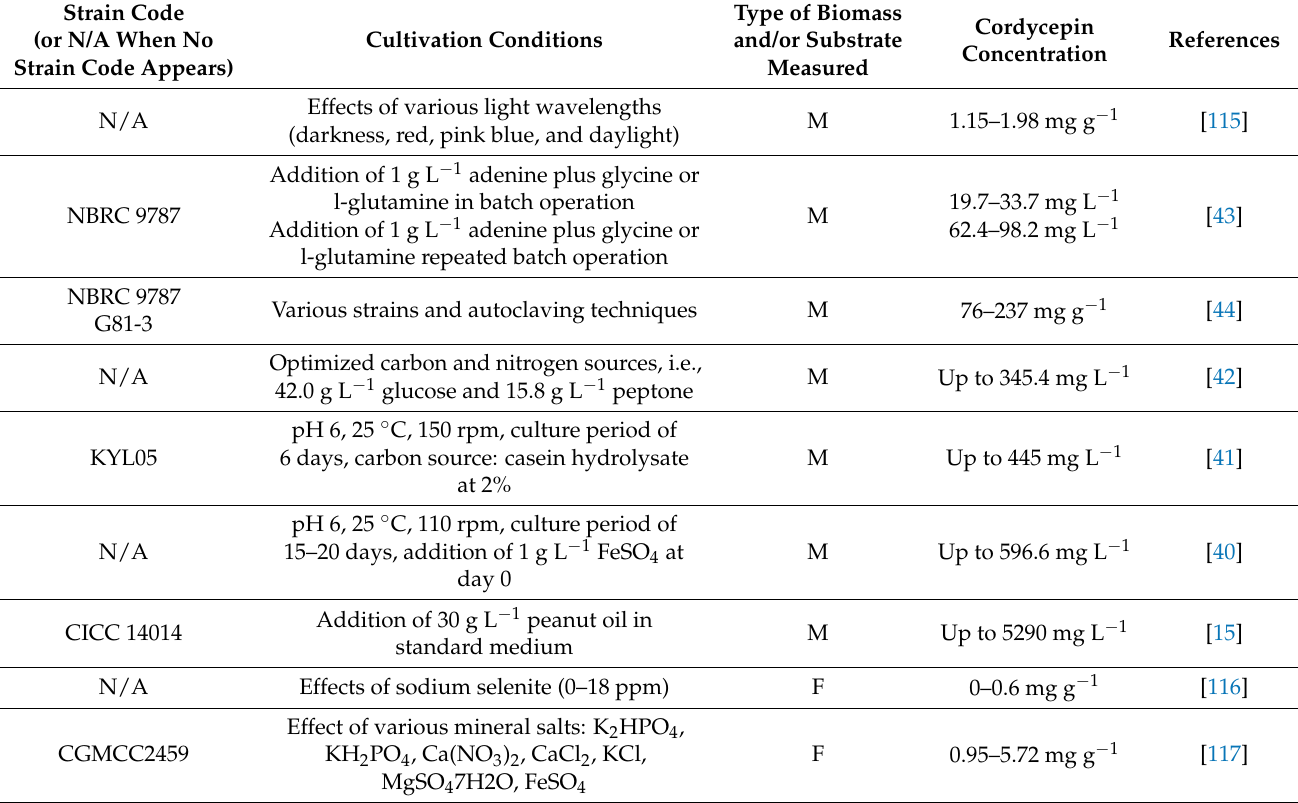
Table 3. Cordycepin production by C. militaris strains as measured in mycelia (M), fruit bodies (F), and liquid media (extracellular, L) under various cultivation